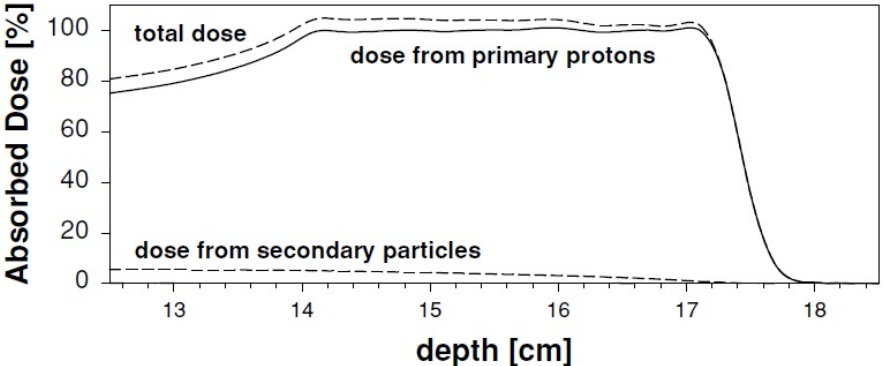
Figure 7. The total absorbed dose along a proton SOBP is shown, by separating contributions coming from primary protons and from secondary fragments (A <